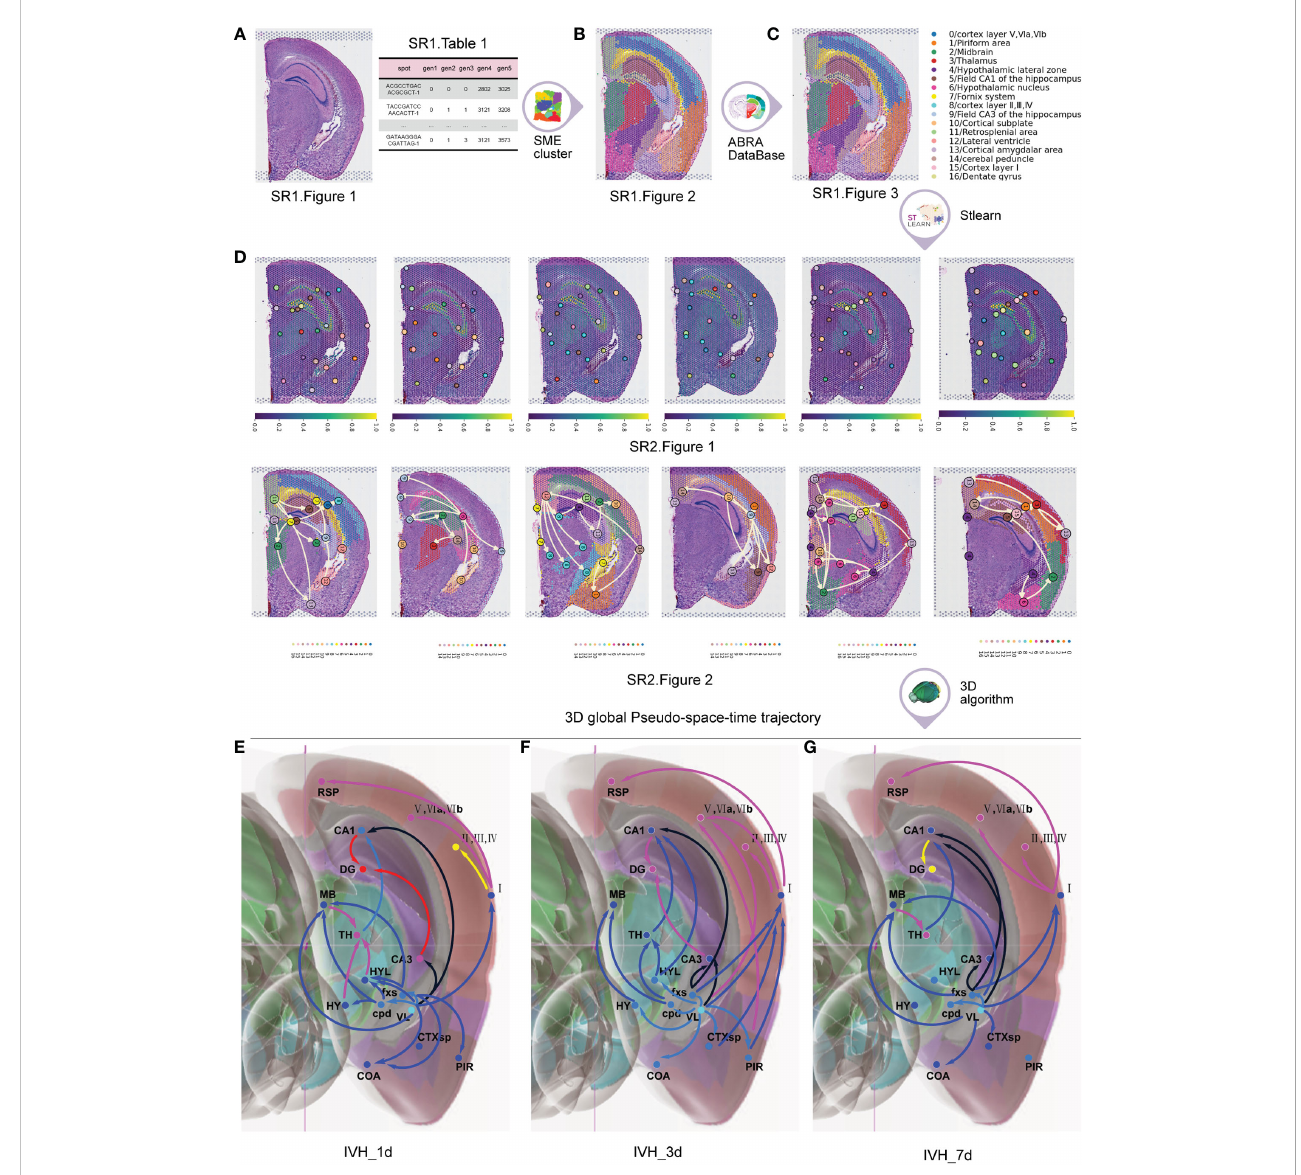
FIGURE 2 The process to obtain the 3D global pseudospace-time trajectory after IVH. (A) Hematoxylin and eosin (H&E)-stained sections and spatial gene expression. (B) Normalization and clustering of the cell types with similar gene expression. (C) Annotation atlas of cell-type clusters. (D) Planar diffusion pseudotime plots and planar global pseudospace-time trajectories. (E) The 3D global pseudospace-time trajectories on the fi rst day after IVH stimulation. (F) The 3D global pseudospace-time trajectories on the third day after IVH stimulation. (G) The 3D global pseudospace-time trajectories on the seventh day after IVH